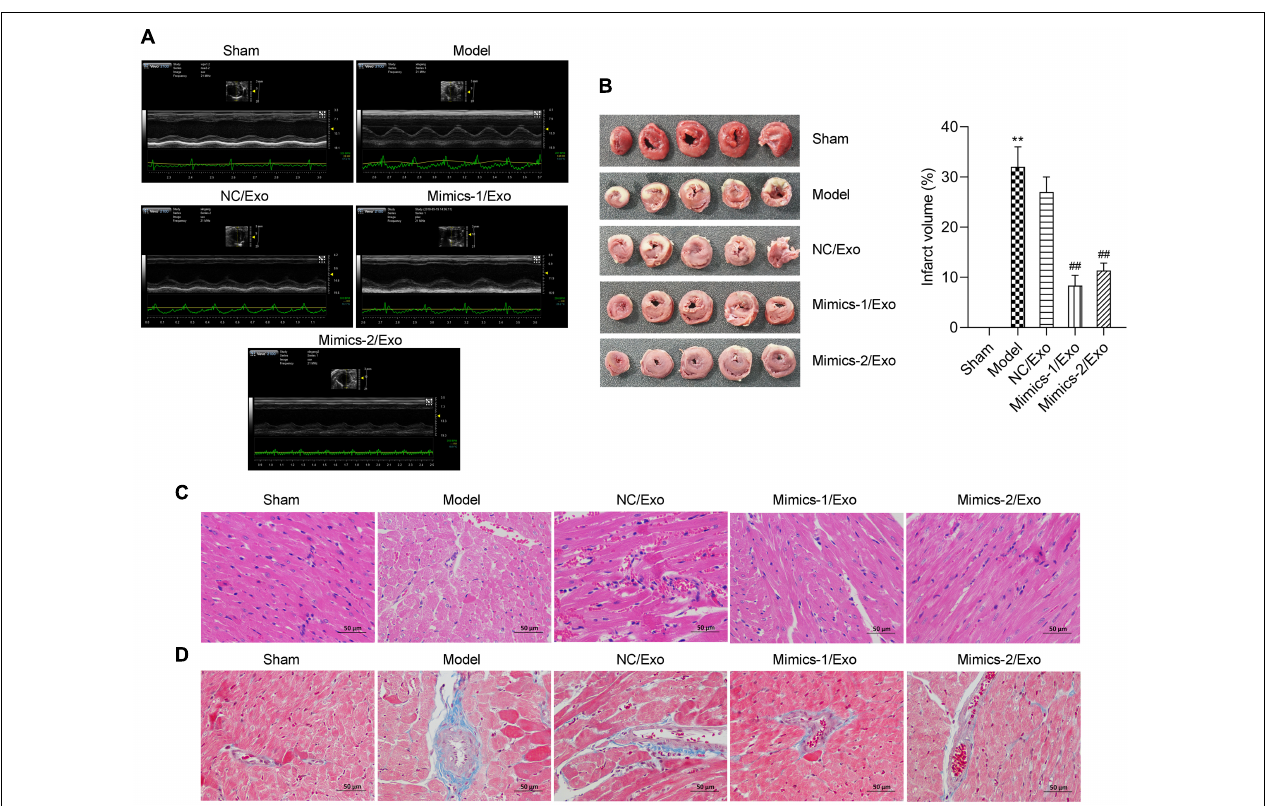
FIGURE 7 | Effects of miR-1246 and miR-1290 in exosomes from EPCs on myocardial infarction in rats. After administration of PBS to sham and model groups, and of exosomes from EPCs transfected with NC/Exo, Mimics-1/Exo, or mMimics-2/Exo, cardiac function was evaluated by echocardiography (A) . Myocardial infarction was evaluated on infarction size through TTC, the infarct volume was measured, and the infarct volume percentage was calculated (B) . The histopathological feature was identified through H&E staining (C) . The degree of tissue fibrosis was determined through Masson staining (D) . N = 10. ** P < 0.01 as compared with the Sham group; ## P < 0.01 as compared to the Model group. Exo, exosomes; Mimics-1, miR-1246 mimics; Mimics-2, miR-1290